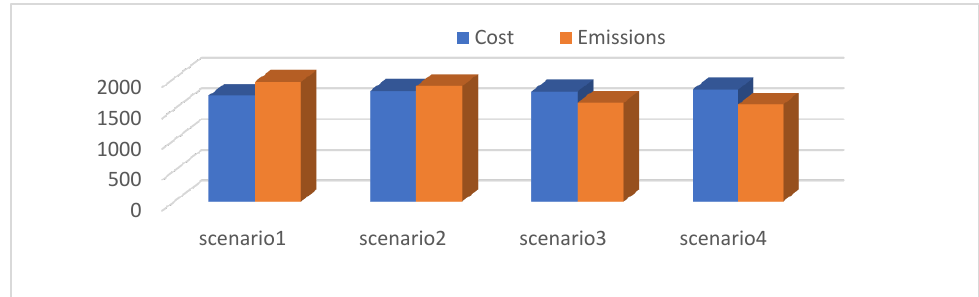
Figure 12. Cost and emissions for all scenarios.